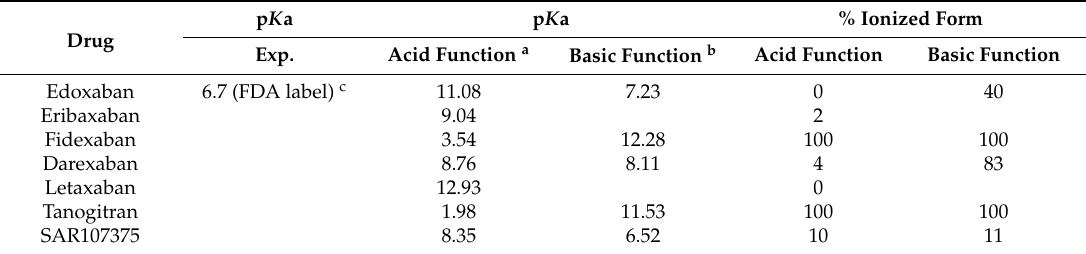
Table 3. The p K a values (at 25 ˝ C) of the anticoagulants investigated (SPARC/p K a). p K a p K a % Ionized Form Drug Exp. Acid Function a Basic Function b Acid Function Basic